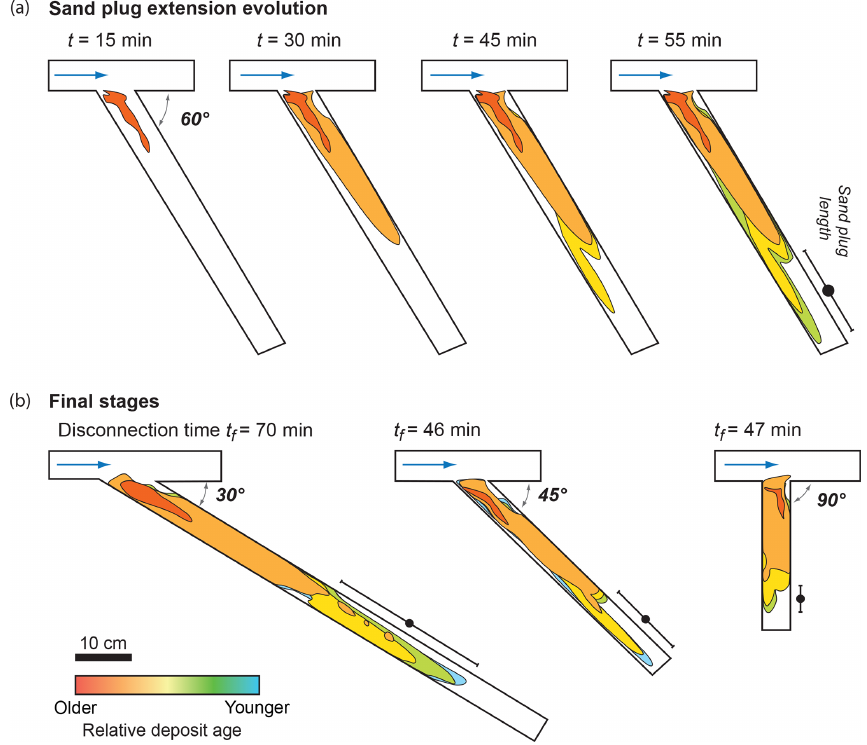
Figure 4. Planar growth of sand plug from overhead pictures. (a) Consecutive growth phases of the sand plug for β 2 = 30 ◦ . (b) Final states of the sand plug for different β 2 angles. Contours are drawn every 15min. The mean sand plug length is represented with a black circle, together with uncertainties.